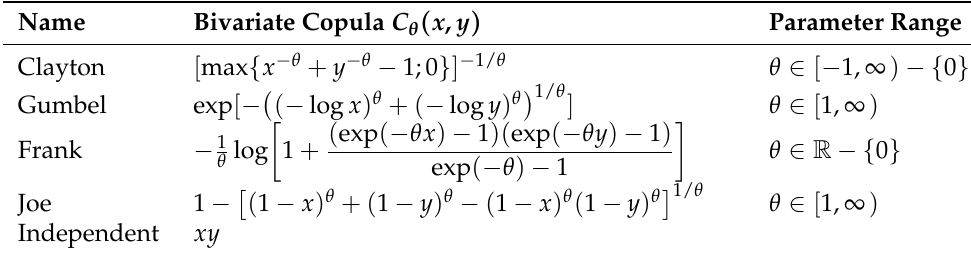
Table 2. Popular Archimedean copulas